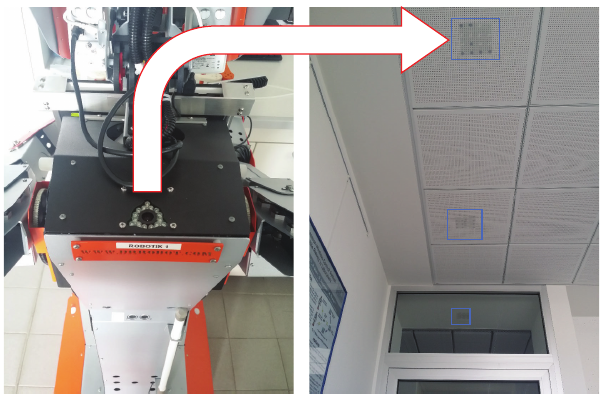
Figure 4: SGM installed on H20 and the ceiling landmarks [20].